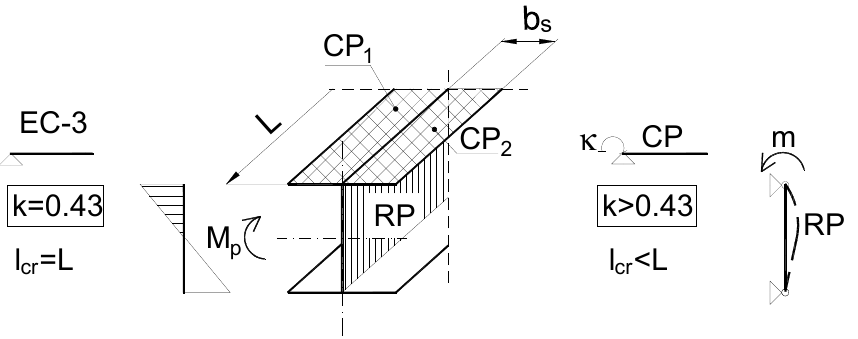
Figure 2. Division of I-cross-section into critical plate (CP) and restraining plate (RP) for h < h 0 .